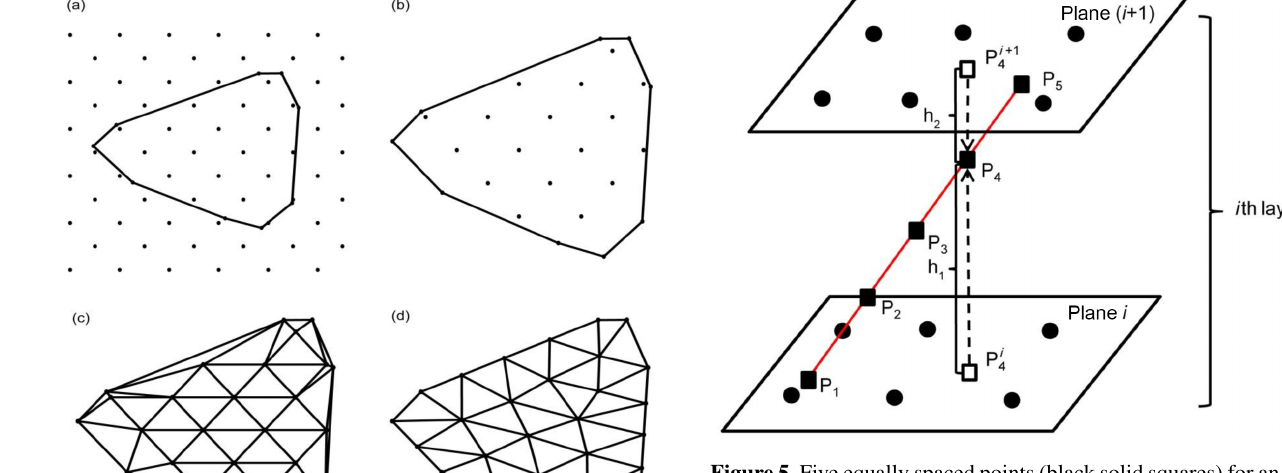
Figure 5. Five equally spaced points (black solid squares) for an ap- proximation of wet refractivity for the i th layer. P i and P i + 1 (black 4 4 hollow squares) are the projected points of P 4 on the i th and ( i + 1)th planes, respectively, h 1 is the height difference between P 4 and P i , 4 and h 2 is that between P 4 and P i + 1 4